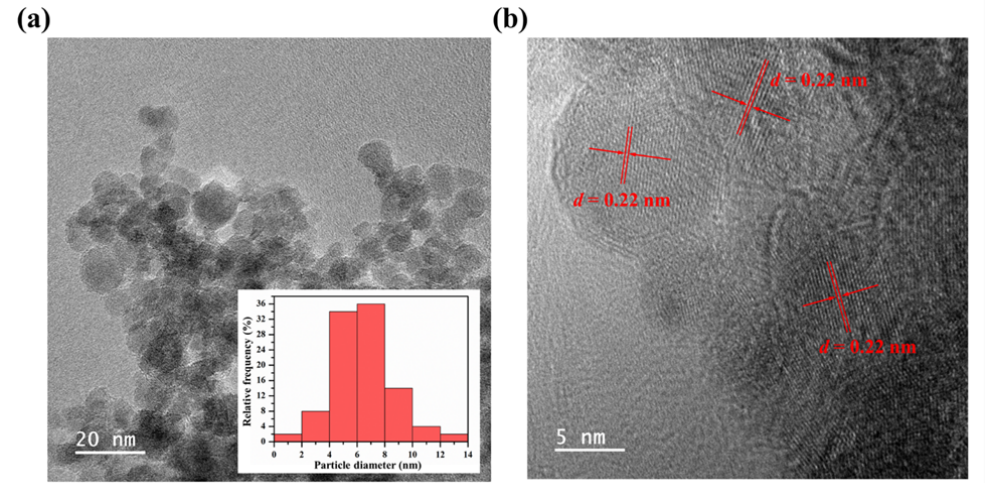
Figure 2. ( a ) TEM image and the size distribution (inset) of GQDs and ( b ) HR-TEM image of GQDs and a lattice spacing of approximately 0.22